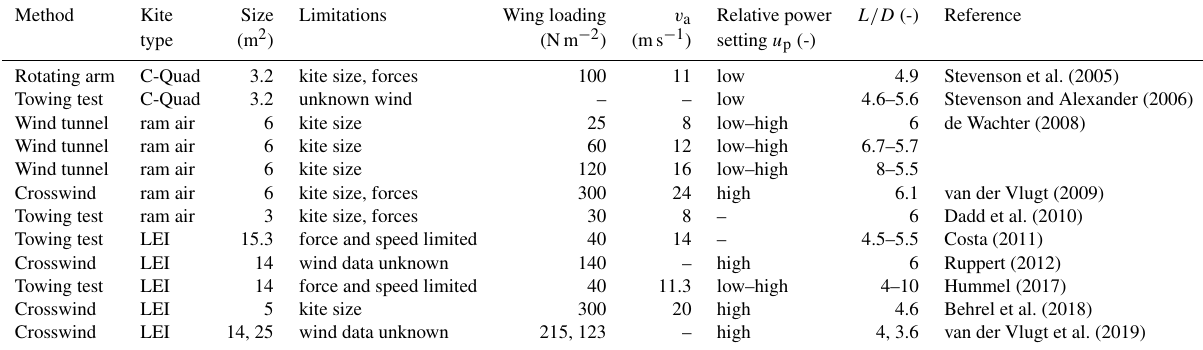
Table 1. Experimental methods for determining the lift-to-drag ratio of soft kites. Size refers here to total wing surface area. Method Kite Size Limitations Rotating arm